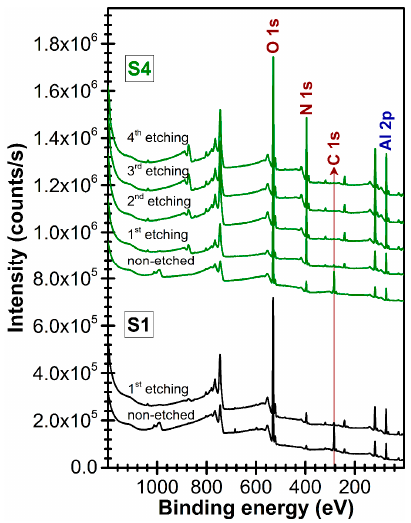
Figure 6. Comparative XPS spectra of S1 and S4 films, before and after the surface argon ion etching stages.